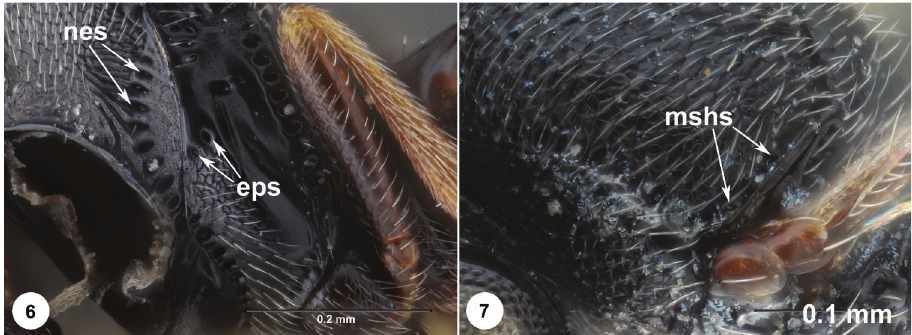
Figures 6–7. Trissolcus colemani 6 female (FSCA 00093972), mesosoma, ventrolateral view 7 female (FSCA 00094244), mesosoma, dorsolateral